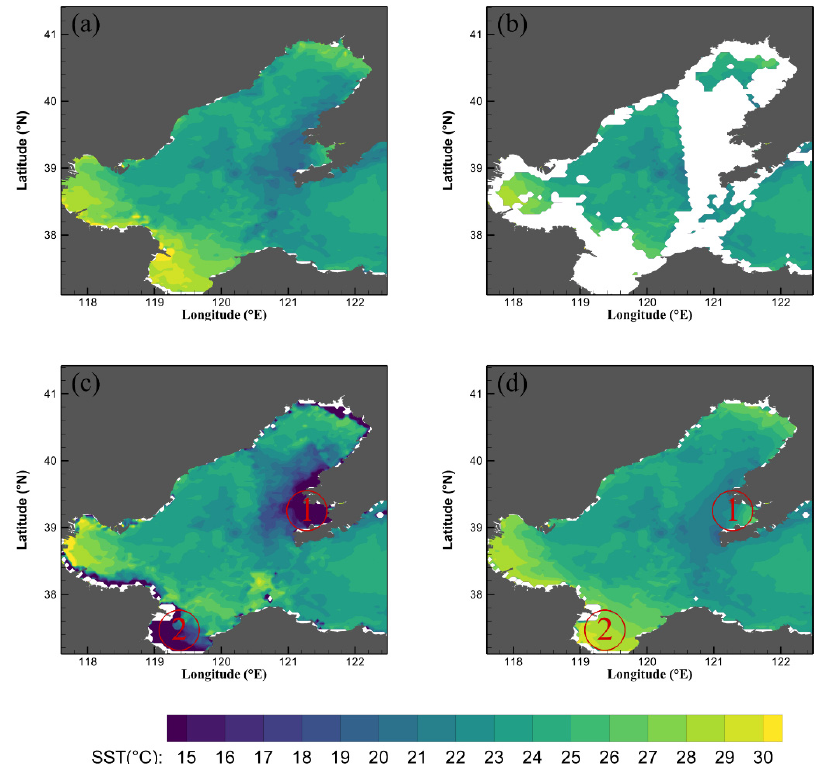
Water 2023 , 15 , x FOR PEER REVIEW 12 of 17